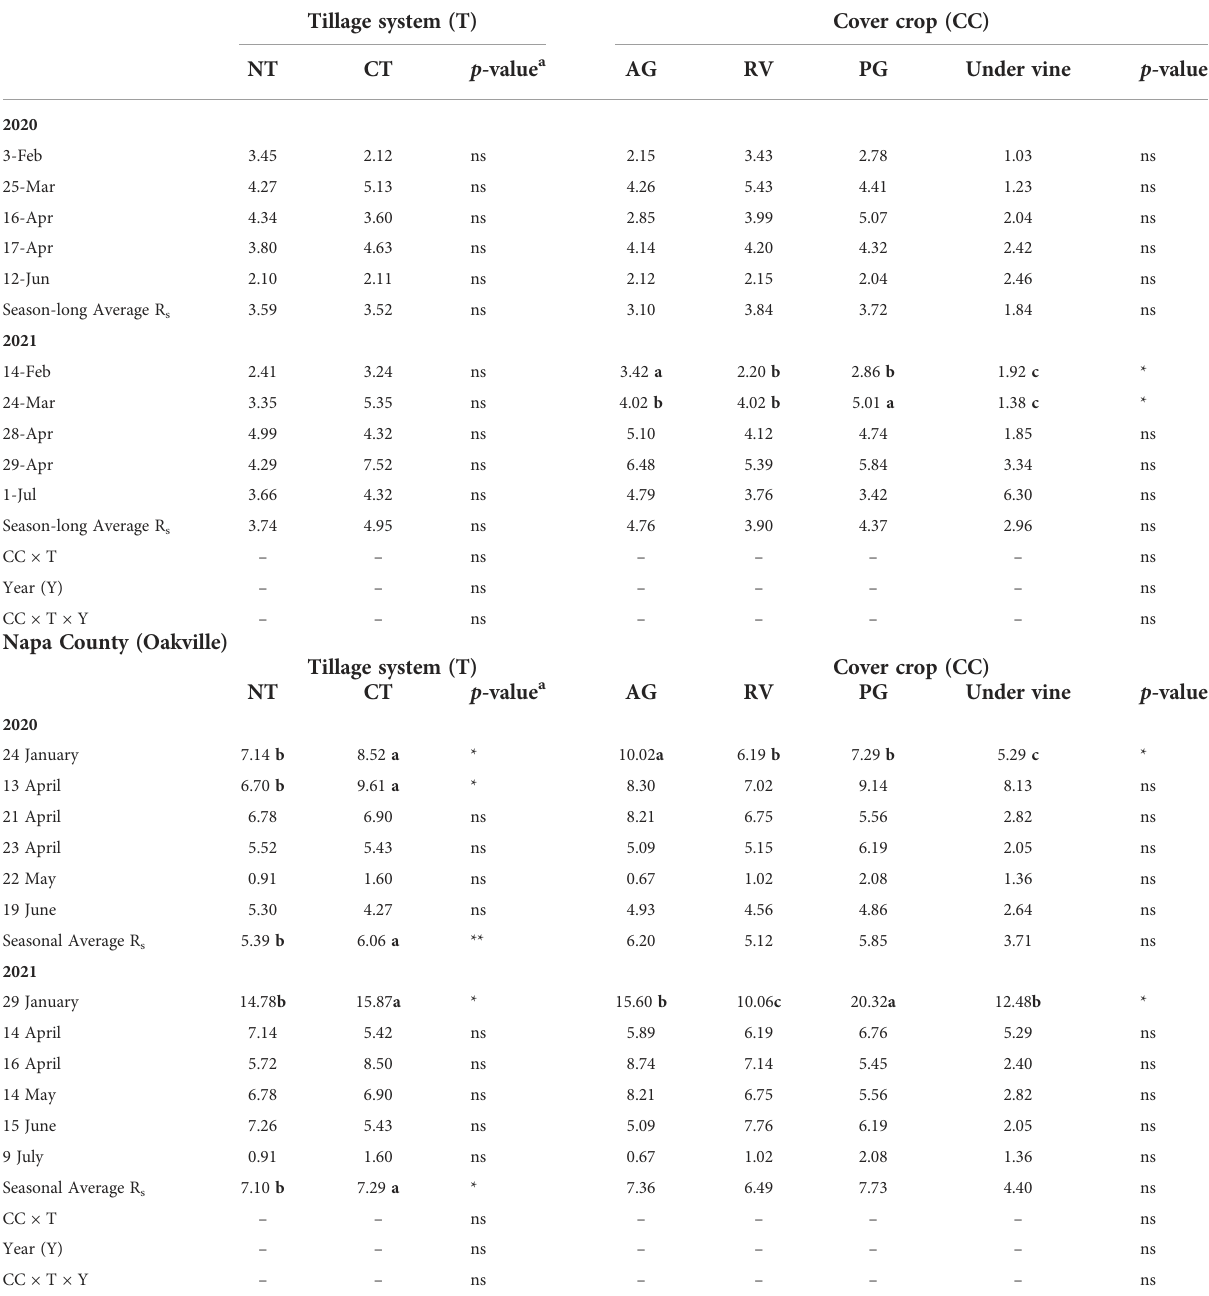
TABLE 3 Average soil respiration (R s ) (t C ha -1 year -1 ) analyzed over the 2-year study across fi ve (Fresno) and six (Napa) timepoints as measured in each cover crop and tillage treatment combination and under vine (bare soil). Fresno County (Five points) Tillage system